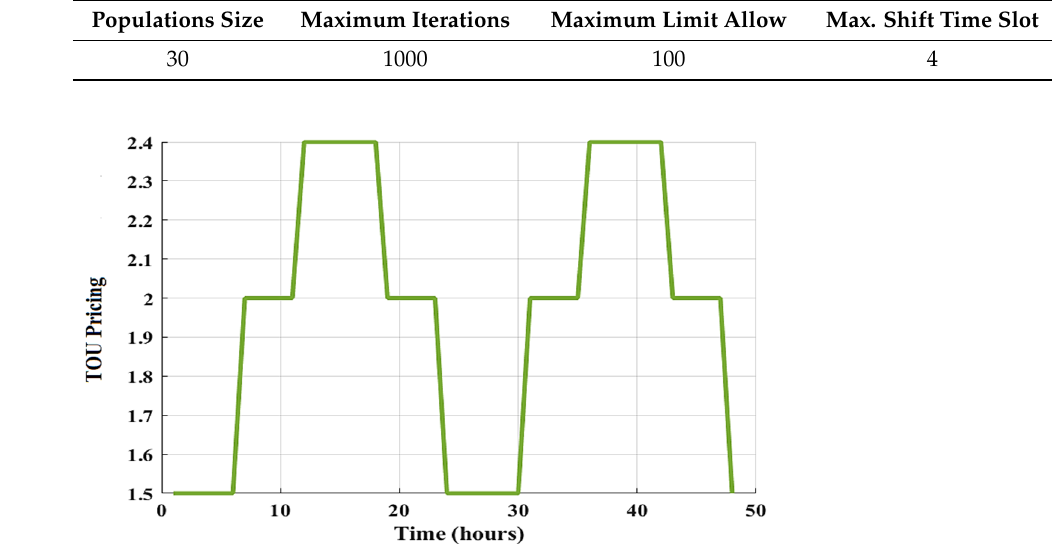
Figure 5. The adopted ToU signal.